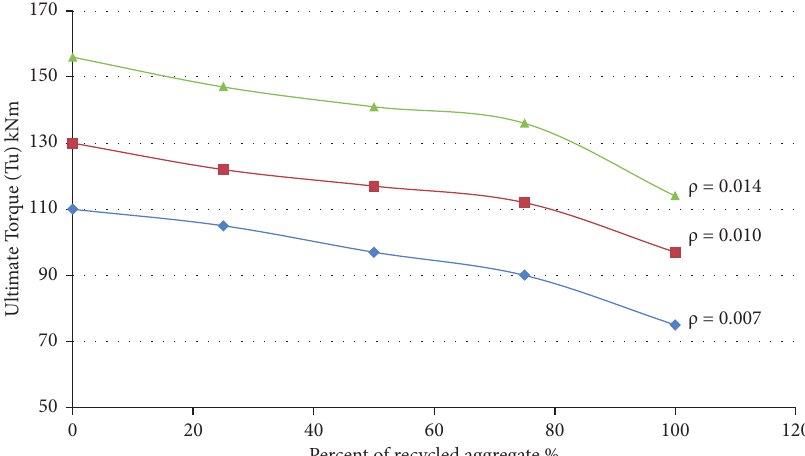
Figure 7: Relation between the ultimate load and the percent of recycled aggregate for different ratios of longitudinal reinforcement.